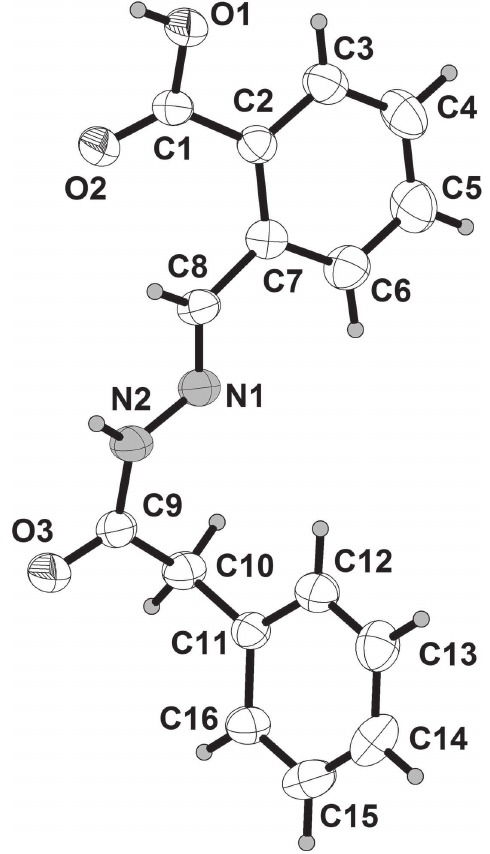
Table 1: Data collection and